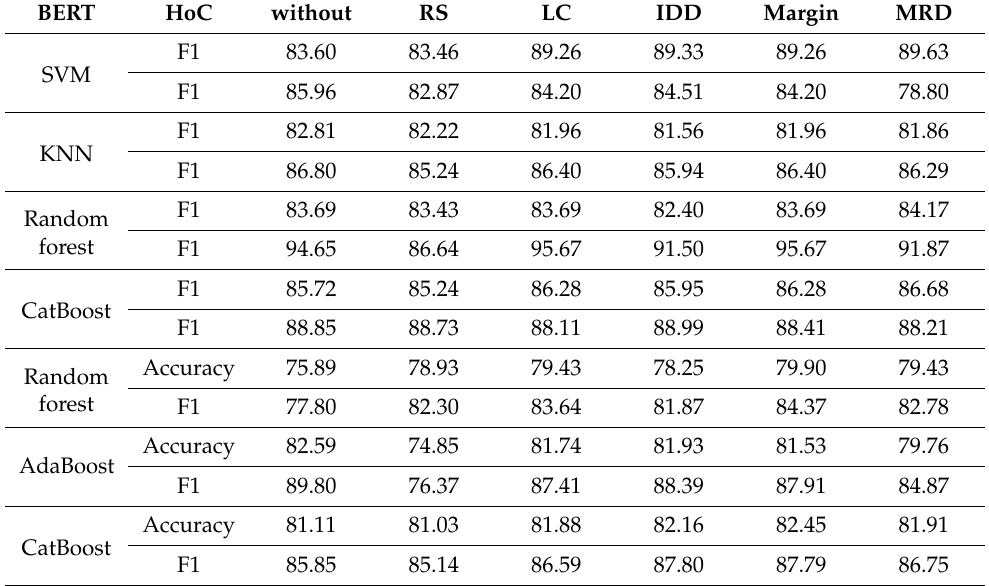
Table 9. Comparison of results with and without AL methods (BERT) for HoC